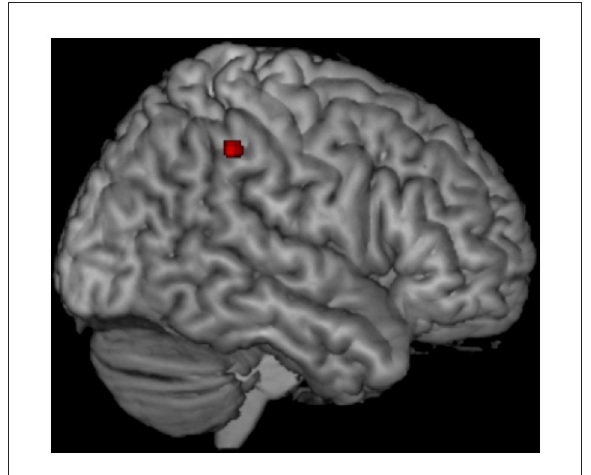
FIGURE1 Voxel-based morphometry (VBM) results. Voxel-based analysis showing gray matter (GM) volume loss in TARDBP MND patients relative to healthy controls. Results are overlaid on a three-dimensional rendering of the Montreal Neurological Institute standard brain and displayed at p < 0.05 corrected for multiple comparisons. Only clusters comprising at least 20 contiguous voxels are shown. Analysis is corrected for intracranial volume, age, sex, and MR scanner